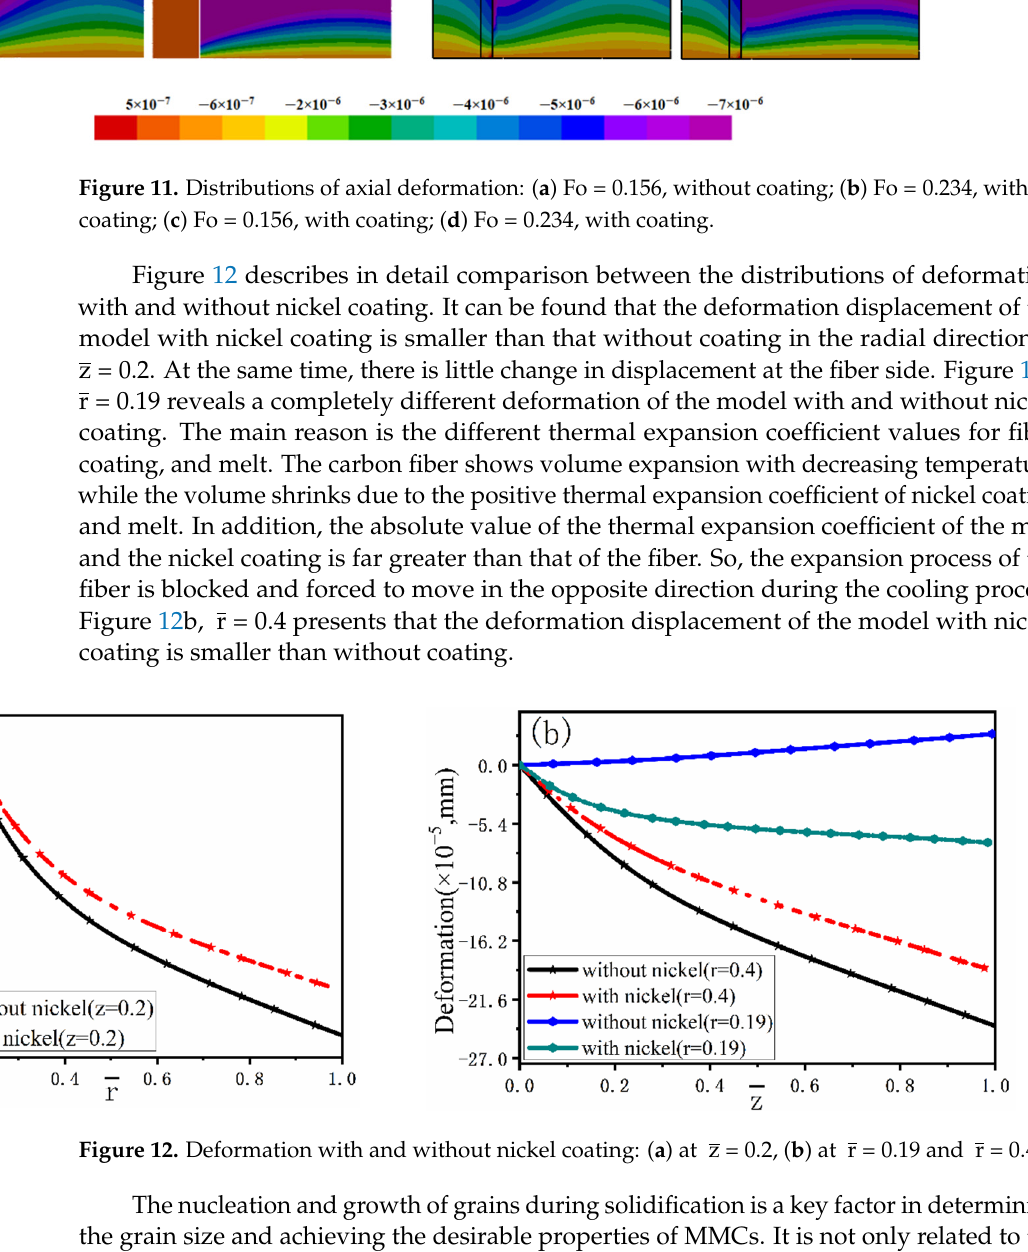
Figure 12. Deformation with and without nickel coating: ( a ) at z(cid:3364) = 0.2, ( b ) at r̅ = 0.19 and r̅ = 0.4.